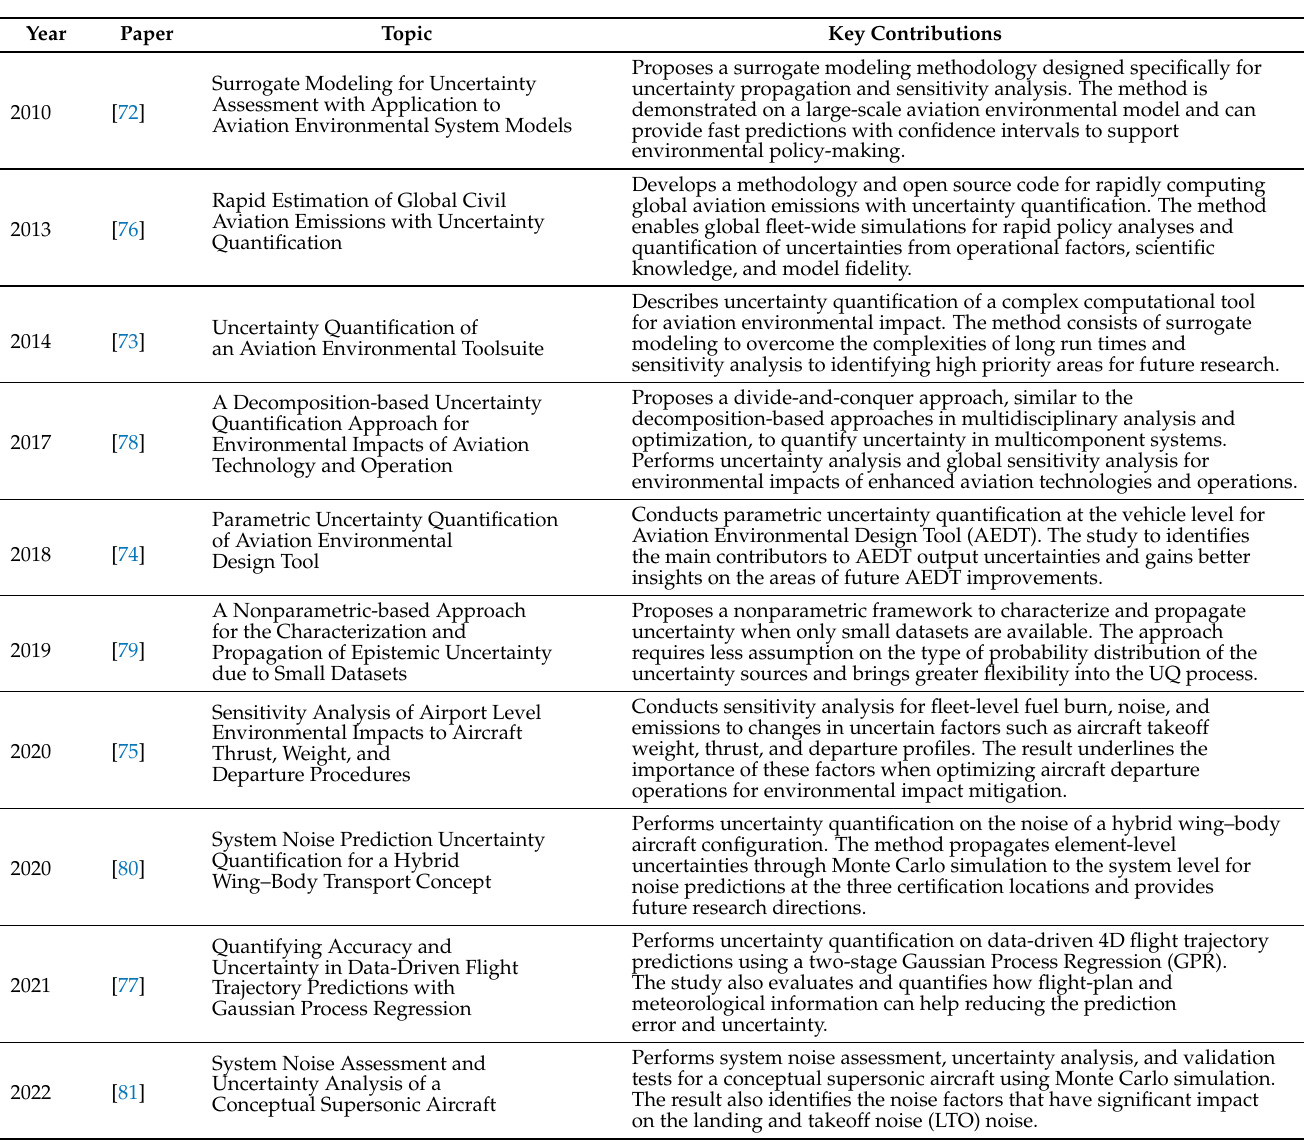
Table 5. Summary of representative papers in uncertainty